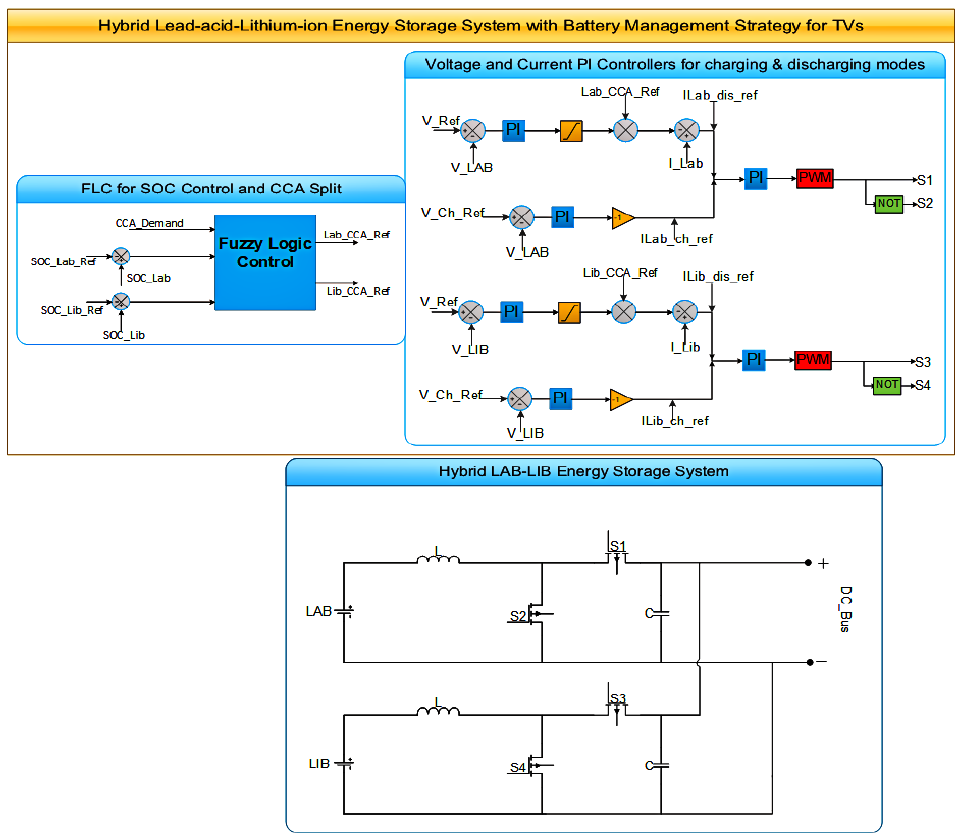
Figure 6. Proposed hybrid energy storage system for ICEVs.